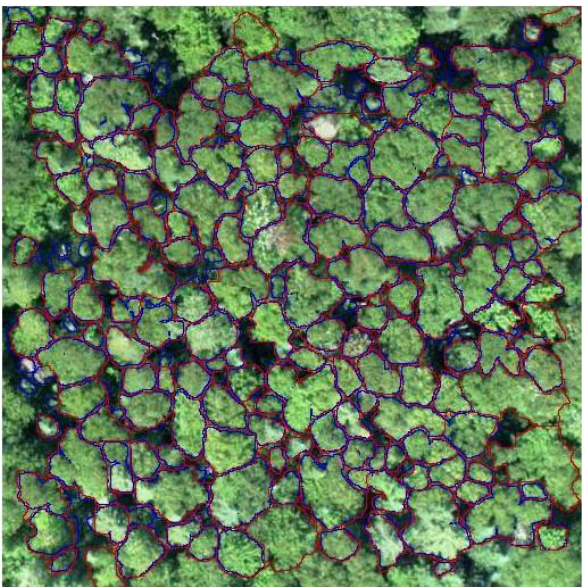
Figure 10 . ITC delineation result (blue circle) generated by attention U-net, together with the tree crowns manually labelled (red circles) for the test size